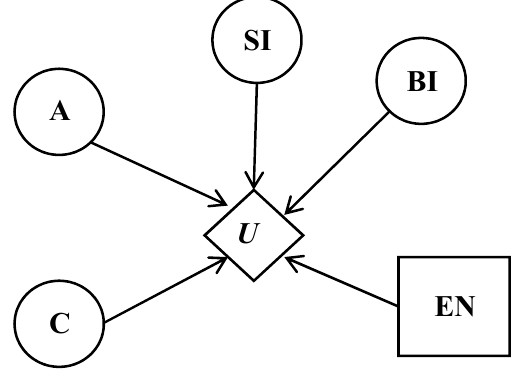
Figure 3. Bayesian network (BN) for effective number of people.